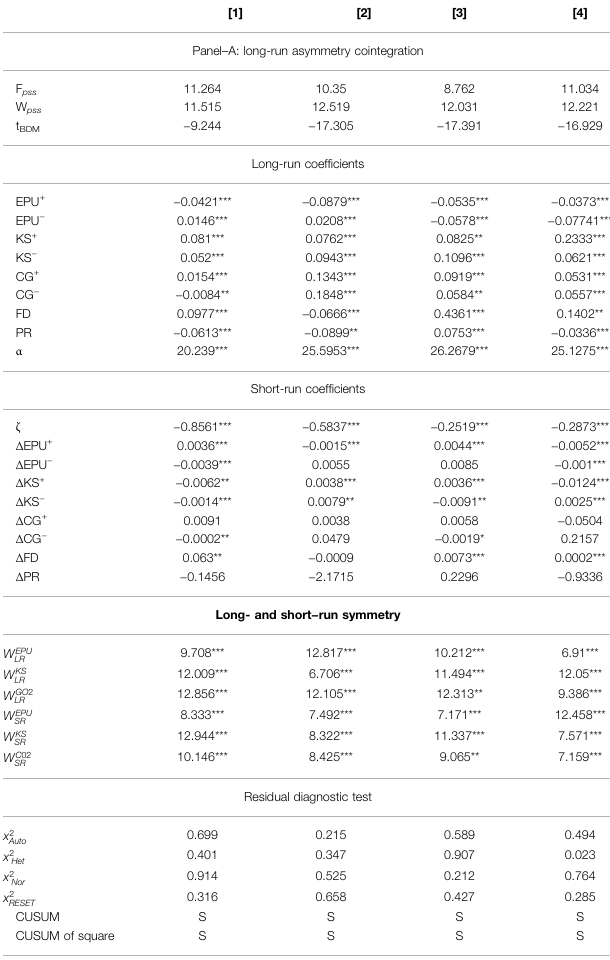
TABLE 7 | Results of an asymmetric